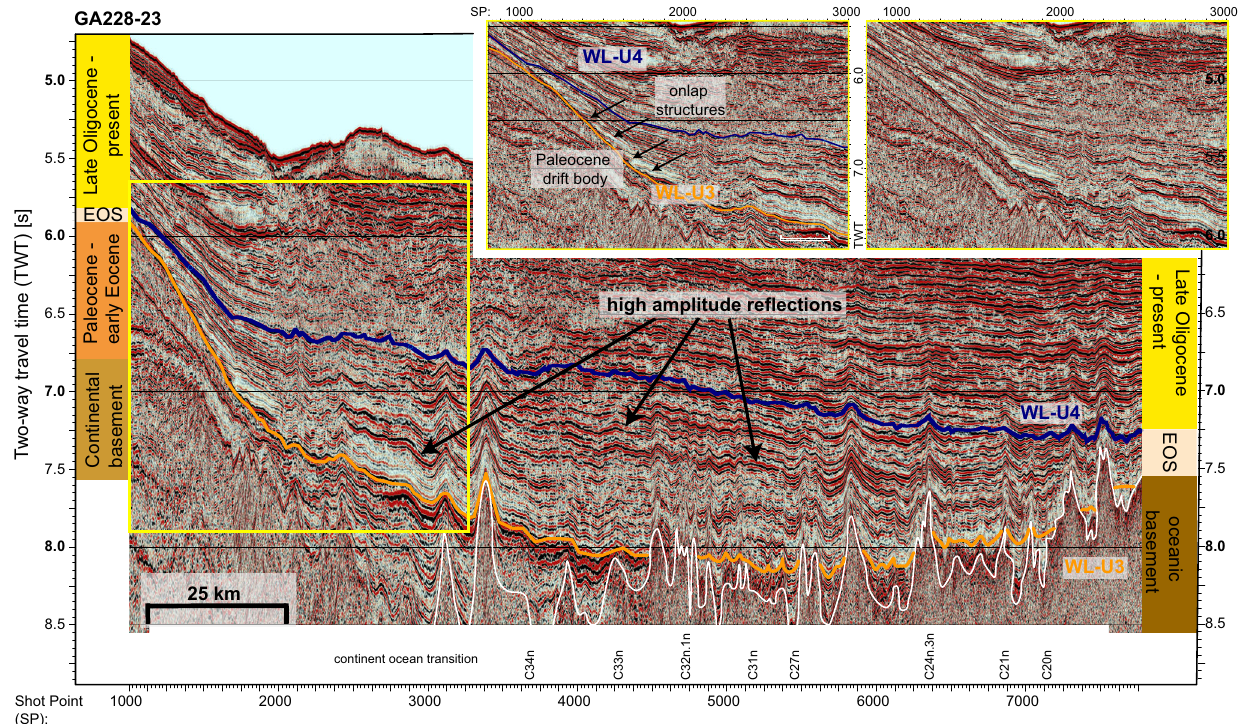
Fig. 2 | Seismic re fl ection pro fi le GA228-23: interpreted seismic re fl ection pro fi leGA228-23offshorePorpoiseBay(forlocationseedarkredlineinFig.1). Orange line marks unconformity WL-U3 (hiatus 48 – 34Ma), blue line marks unconformity WL-U4 (27Ma). High amplitude re fl ectors indicate chert-like deposition. The white re fl ector indicates the oceanic basement. Sea fl oor magnetic